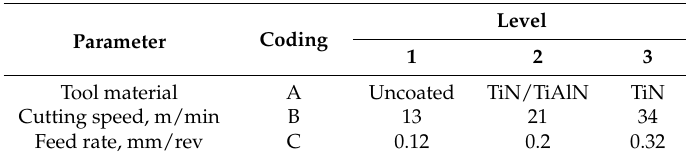
Table 4. Design factors and their levels for drilling tests.